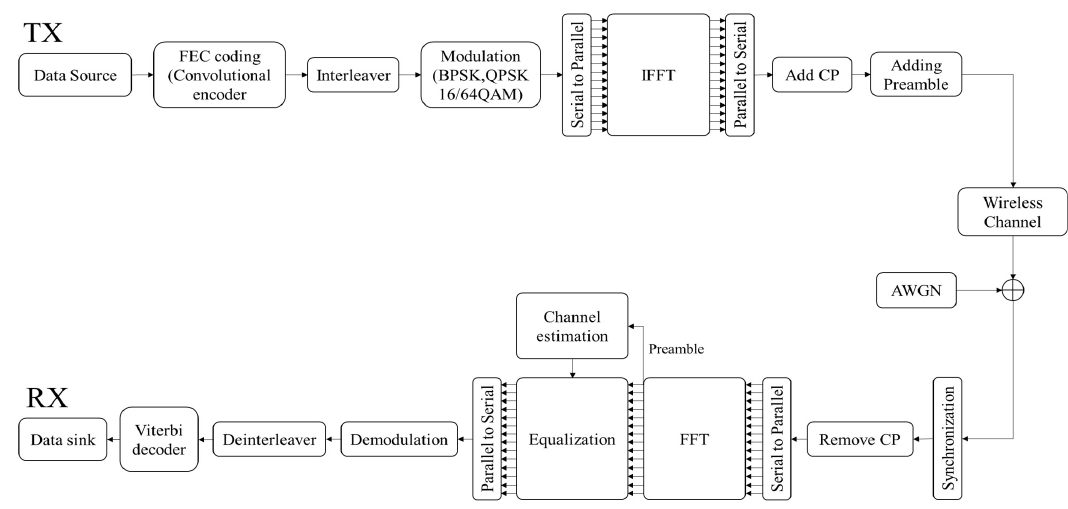
Figure 1. Block diagram of transmitter and receiver in OFDM system.